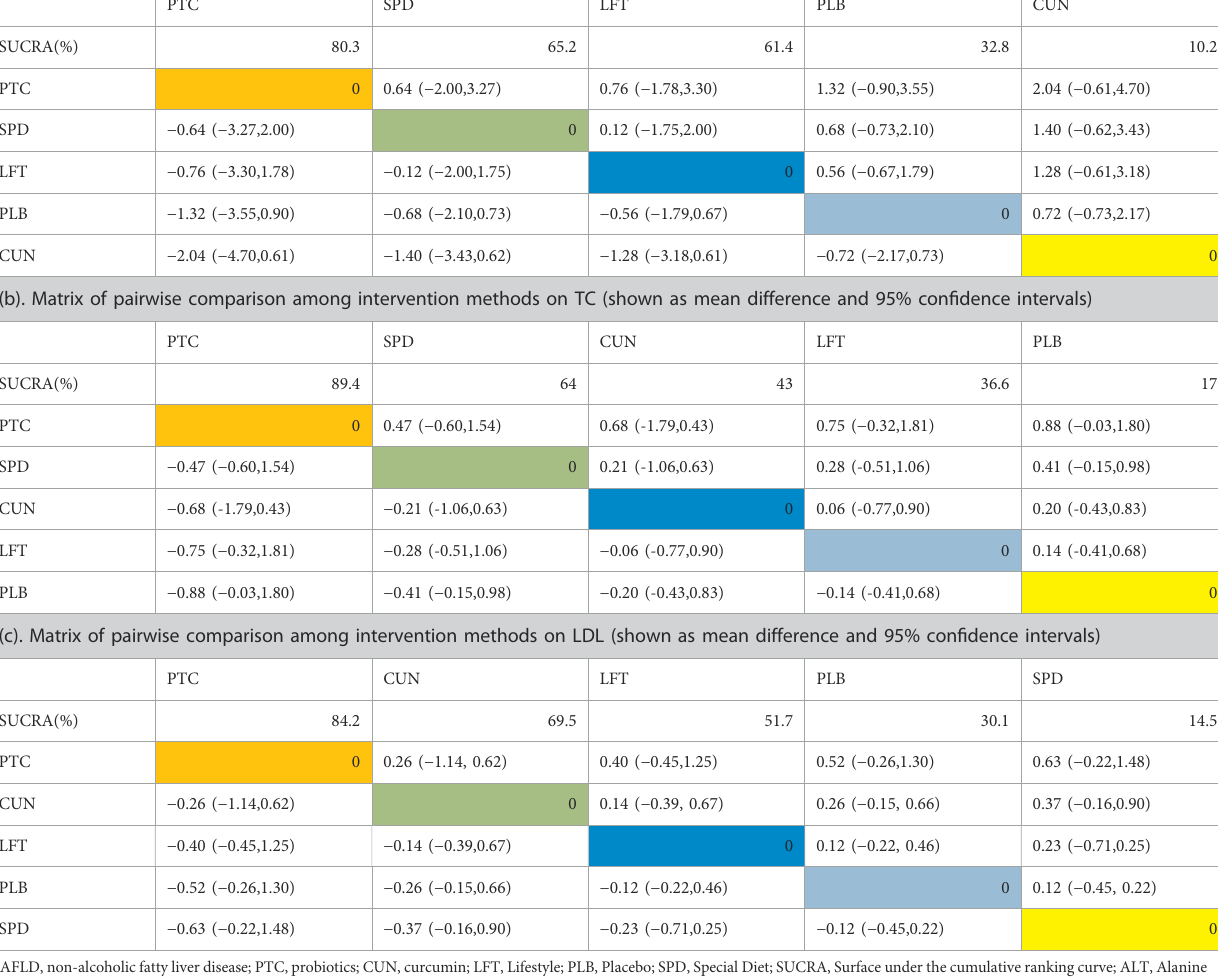
TABLE 2 Matrix of pairwise comparison among intervention methods for NAFLD-related indicators. (a). Matrix of pairwise comparison among intervention methods on ADL (shown as mean difference and 95% con fi dence intervals)